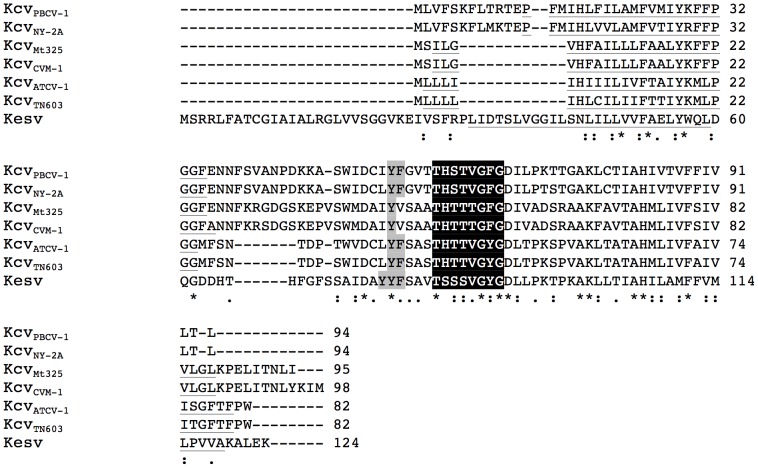
Multiple sequence alignment of K+ channel proteins from different phycodnaviruses.The genes that code for these proteins, originate from viruses with different host specificities. KcvPBCV-1 and KcvNY-2A are from viruses that replicate in C. variabilis, KcvMT325 and KcvCVM-1 from viruses that replicate in M. conductrix, and KcvATCV-1 and KcvTN603 from viruses that replicate in C. heliozoae. The channel Kesv is from virus EsV-1, which replicates in E. siliculosus. The selectivity filter sequence is in black; aromatic amino acids upstream of the filter are marked in grey and the transmembrane domains are underlined.